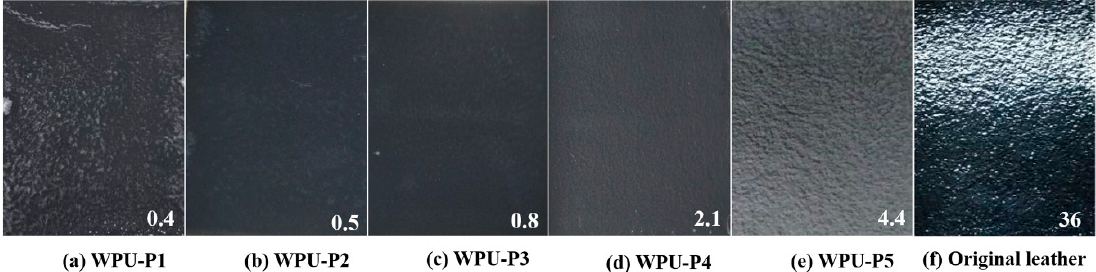
Figure 12. Digital images of leather coated by WPU-P with different PCLD contents.